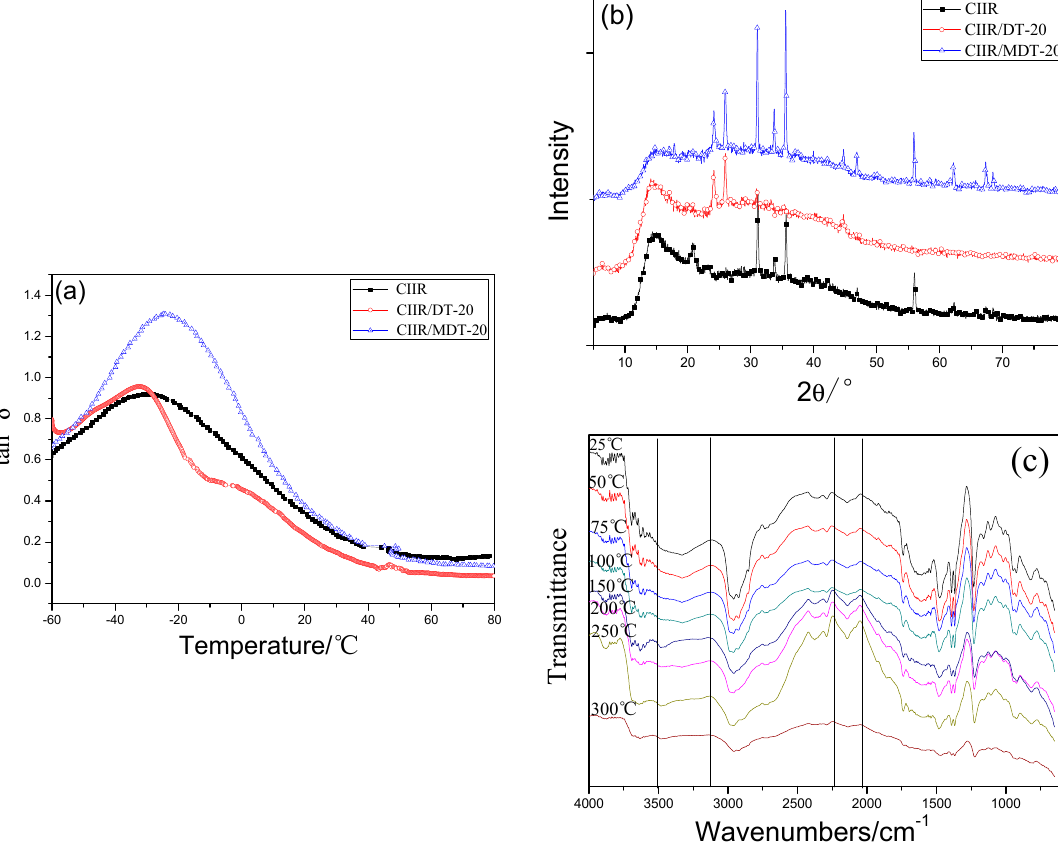
Figure 8. Damping mechanism of CIIR systems: ( a ) tan δ ; ( b ) XRD; and ( c ) in situ variable temperature FTIR spectra of CIIR/MDT-20.